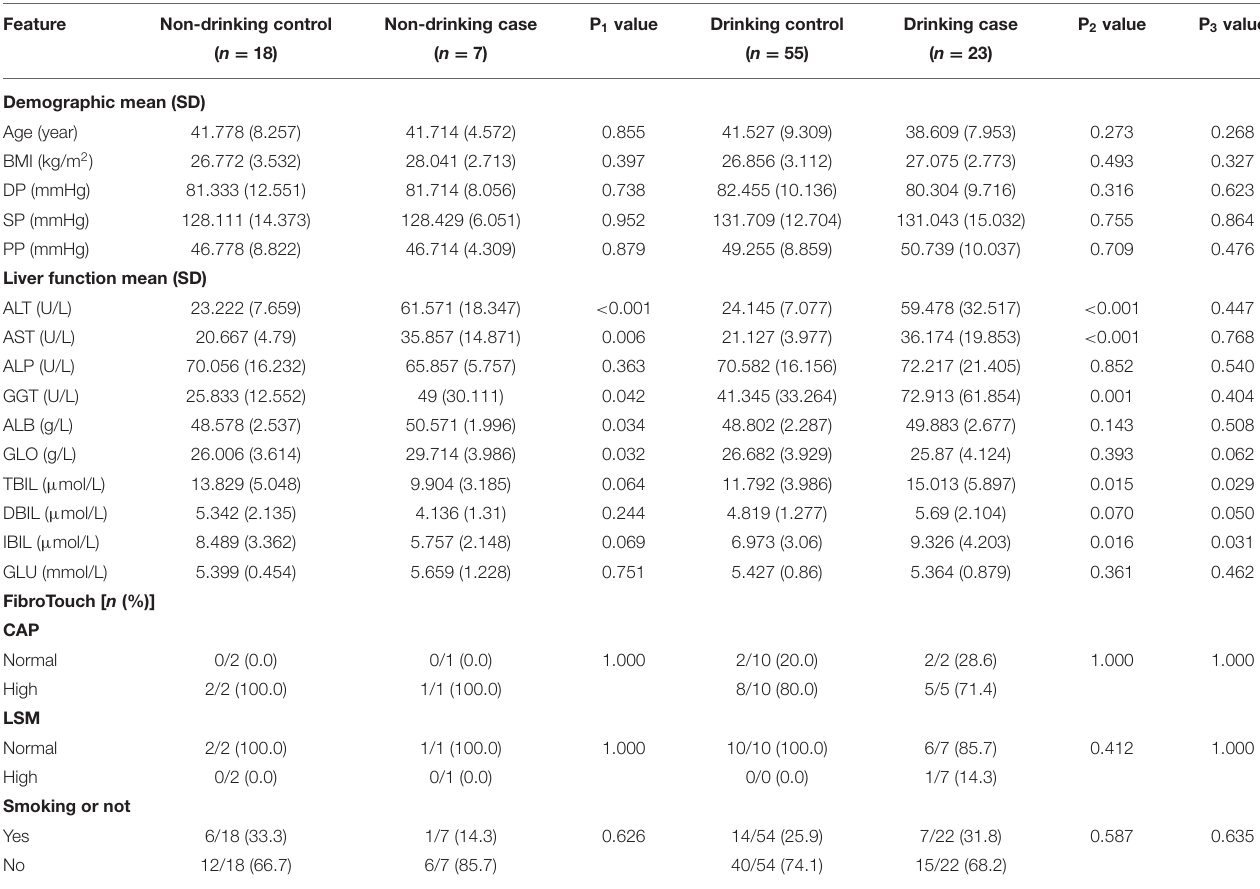
TABLE 1 | Demographic characteristics of the study